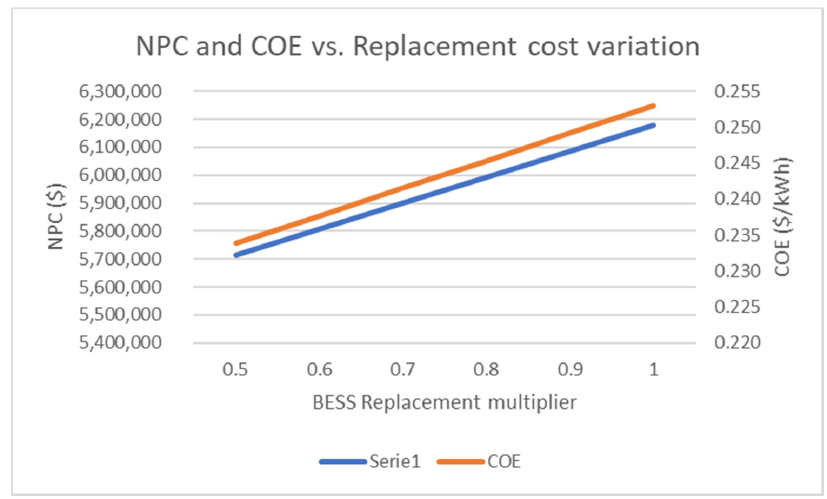
Figure 12. NPC and COE with variation of BESS replacement multipliers.